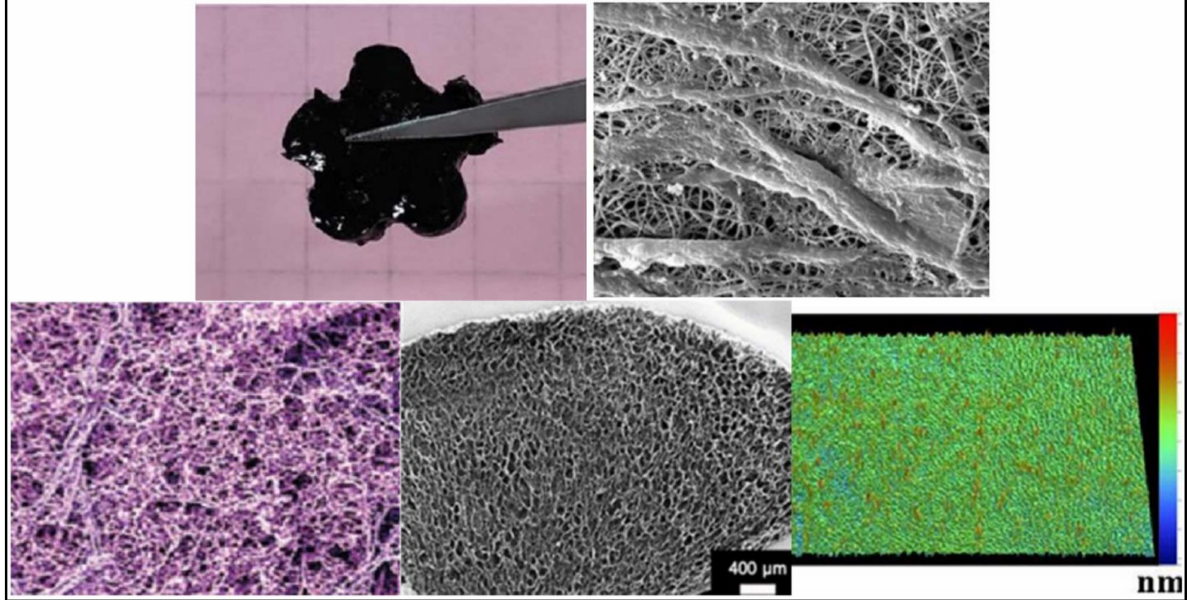
Figure 4. Images of scaffold structures: porous hydrogel, nanofibrous, porous hydrogel scaffold, porous sponge scaffold, and hydrogel patch scaffold